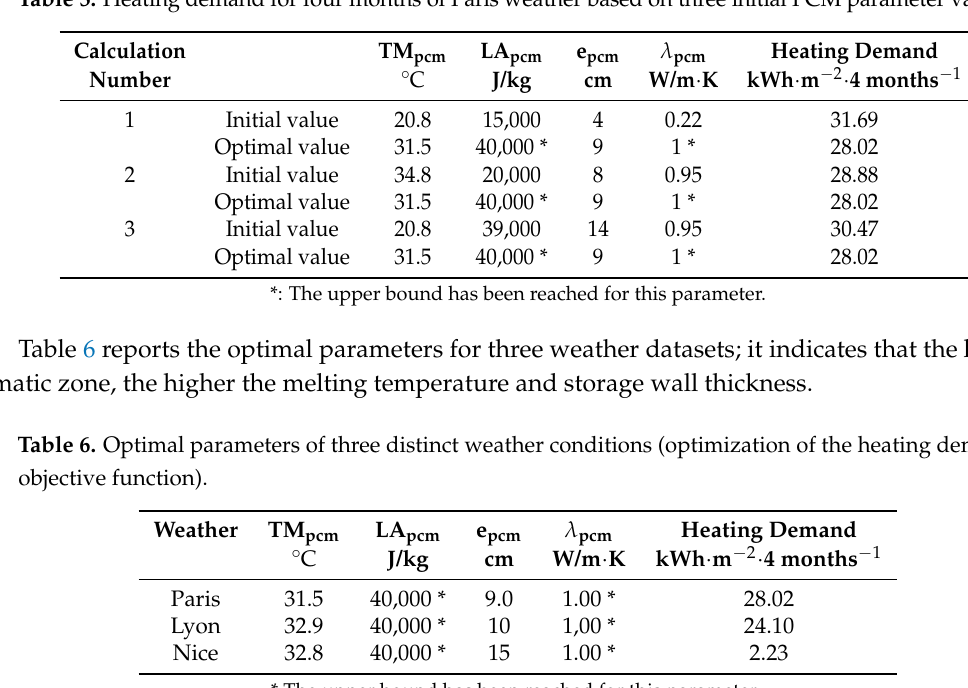
Table 5. Heating demand for four months of Paris weather based on three initial PCM parameter values.